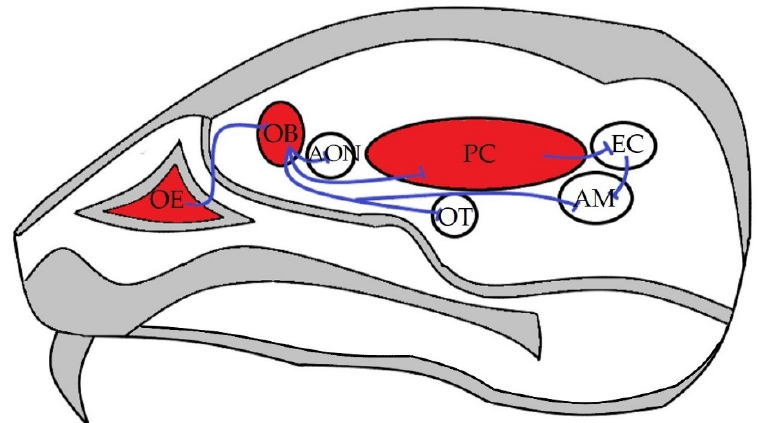
Figure 1. Schematic representation of the mouse olfactory tract. Red colour shows the investigated brain areas, Reprinted from ref [10]. Abbreviations: OE: olfactory epithelium, OB: olfactory bulb, AON: accessory olfactory nucleus, OT: olfactory tubercle, PC: piriform cortex, EC: entorhinal cortex, AM: amygdala .